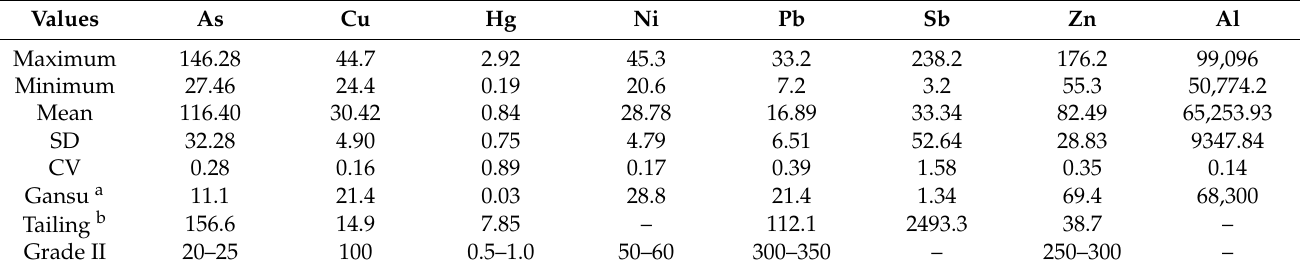
Table 2. Descriptive statistical summary of the potentially toxic element (PTE) concentration (mg kg − 1 ) in the studied